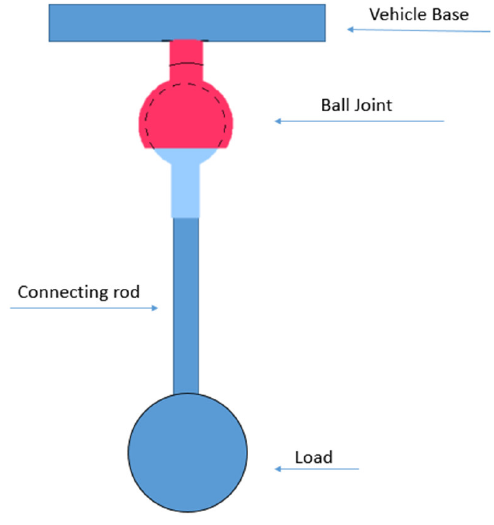
Figure 5. Load fixation.